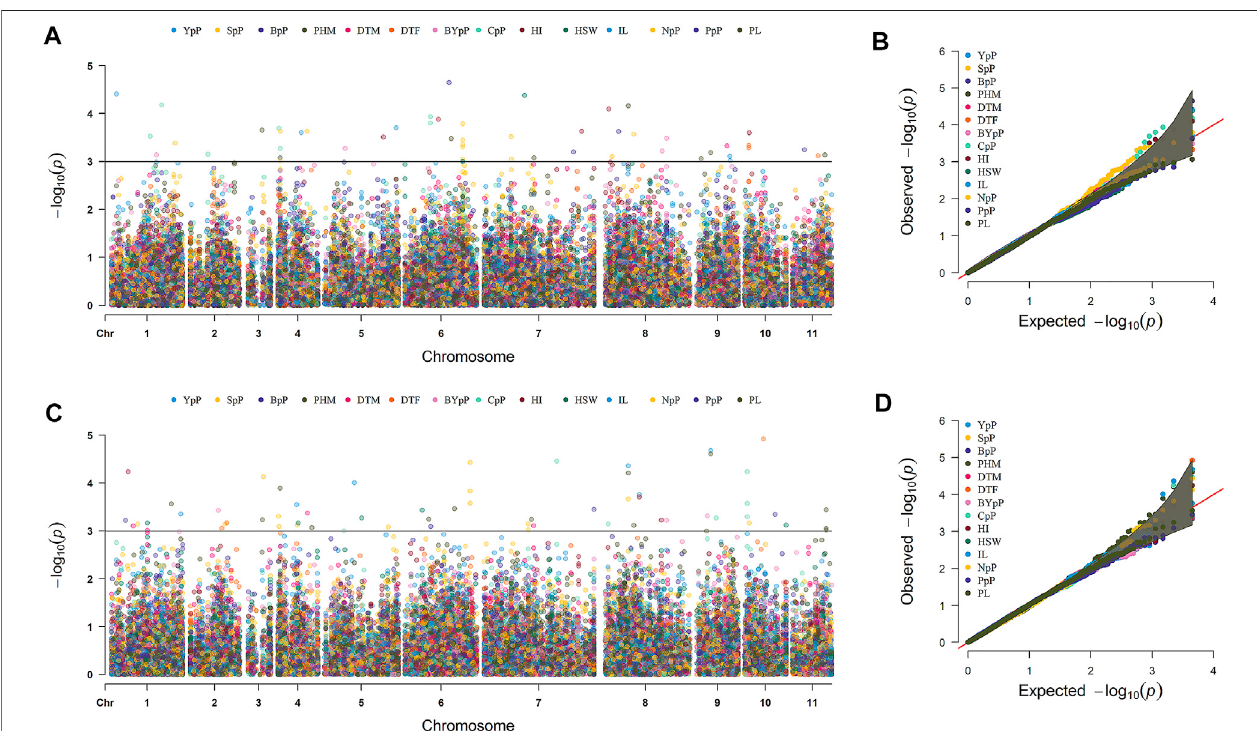
FIGURE 4 | Marker trait associations for different traits detected by genome wide association study across two different locations Ludhiana (A,B) and Gurdaspur (C,D) as manhattan plots and QQ-plots using 4623 SNP markers. # Days to 50% fl owering (DtF); Days to 90% pod maturity (DtM); Plant height at 90% pod maturity (PHM);Nodesperplant(NpP);Internodallength(IL),Clustersperplant(CpP);Podsperplant(PpP);Seedsperpod(SpP);Biologicalyieldperplant(BYpP);Yieldperplant (YpP); hundred seed weight (HSW) and Harvest index